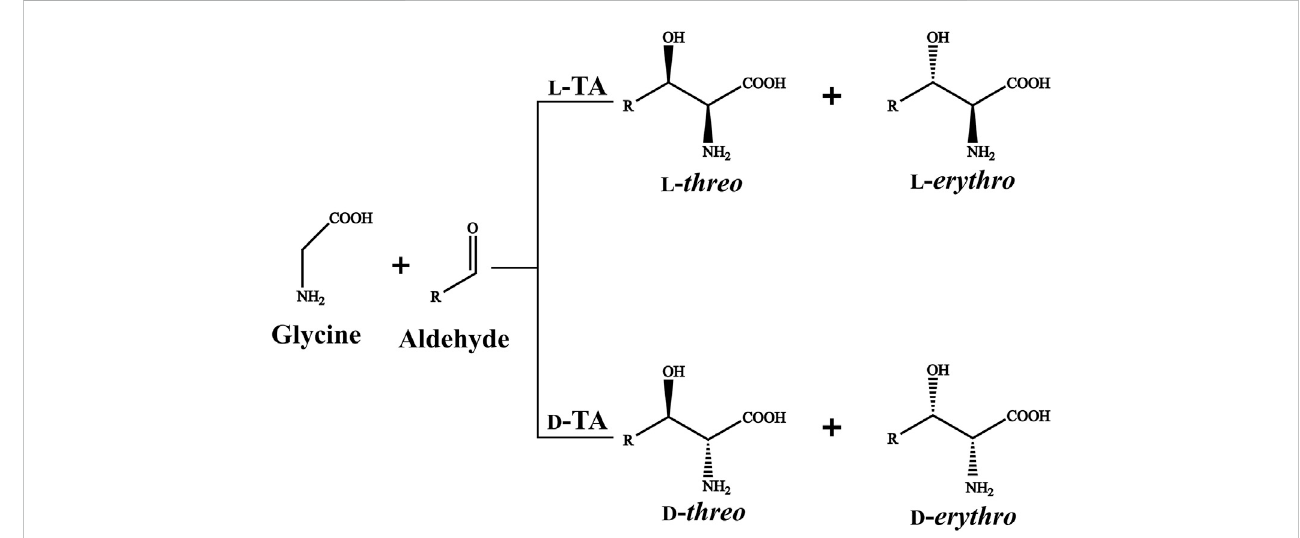
FIGURE 1 L -TA/ D -TA catalyzed